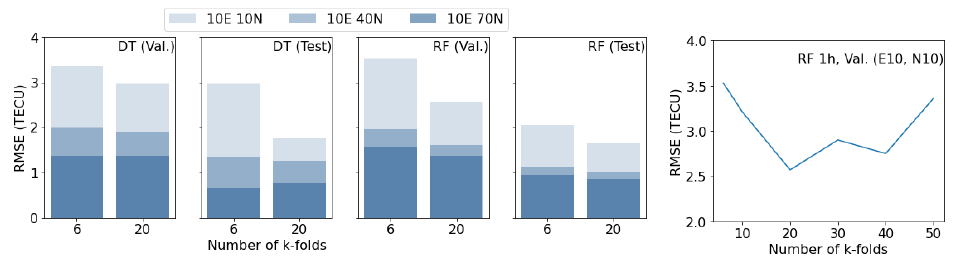
Figure 8. Number of time series k-folds splits as function of RMSE. Left : RMSE for Decision Tree (DT) and Random Forest (RF) on cross-validation and test datasets for k = 6 and 20. Right : RMSE for the RF model on coss-validation data for k = 6, 10, 20, 30, 40, 50. RMSE on training and cross-validation data sets is presented for each k-fold for the model VR1 in Figure 9. Training curves are mostly constant after the 5th fold, while cross- validation curves are changing more significantly. The training set is small in the first folds, which results in lower RMSE during training, as it is easier to fit the smaller dataset. On the other hand, the larger RMSE values are for cross-validation, as such a small training data set is not representative. While increasing the number of k-folds, the training data set becomes larger, which slightly increases RMSE during training, while decreasing RMSE during cross-validation. Thus, the largest errors for the cross-validation are mostly in the first 5 folds. After the 10th fold, RMSE values of cross-validation are similar to RMSE values of training or even smaller as k further increases. The average RMSE values for training and cross-validation for all k-folds are summarized in the bar graphs in Figure 9. Differences in RMSE between training and cross-validation are larger for non-differenced data than for differenced data. Differenced data have a lower training RMSE, while the cross-validation RMSE is mostly similar between differenced and non-differenced